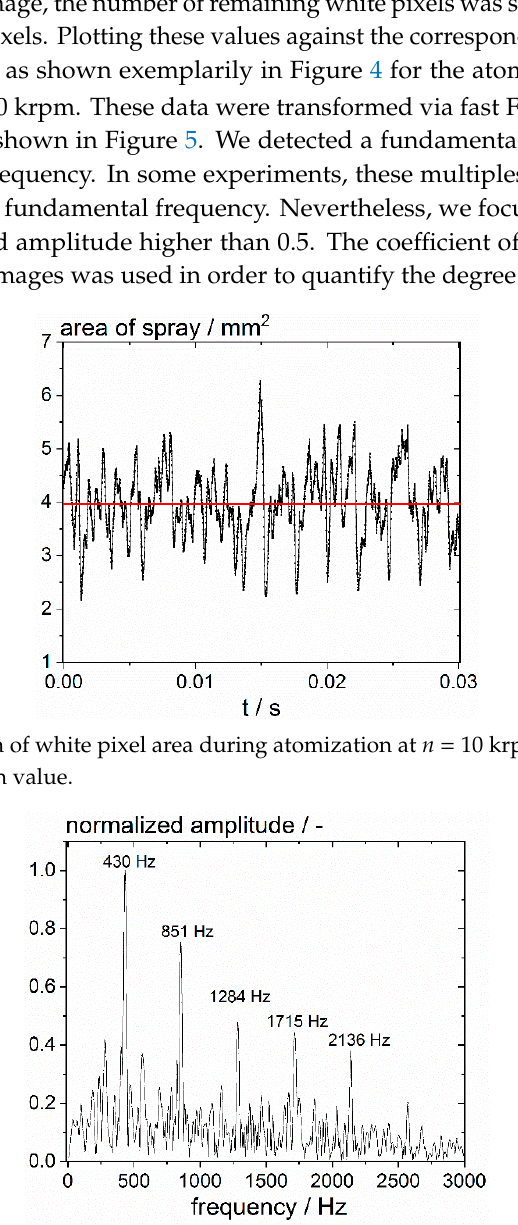
Figure 5. Frequency spectrum of data from Figure 4. Amplitude is normalized with the value of the highest amplitude of the spectrum.